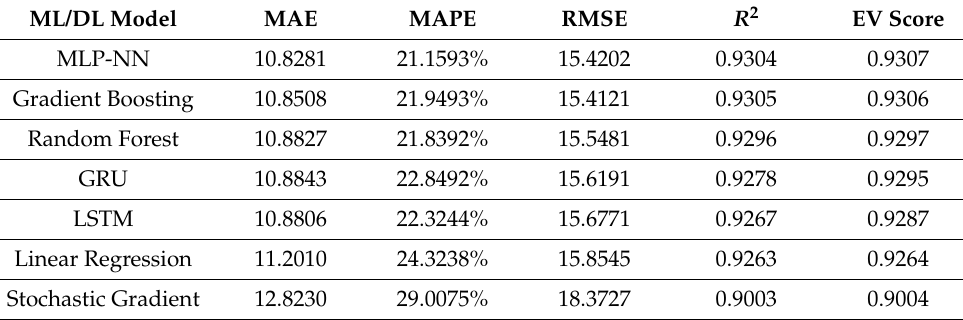
Table 1. Comparison of performance metrics using the first dataset